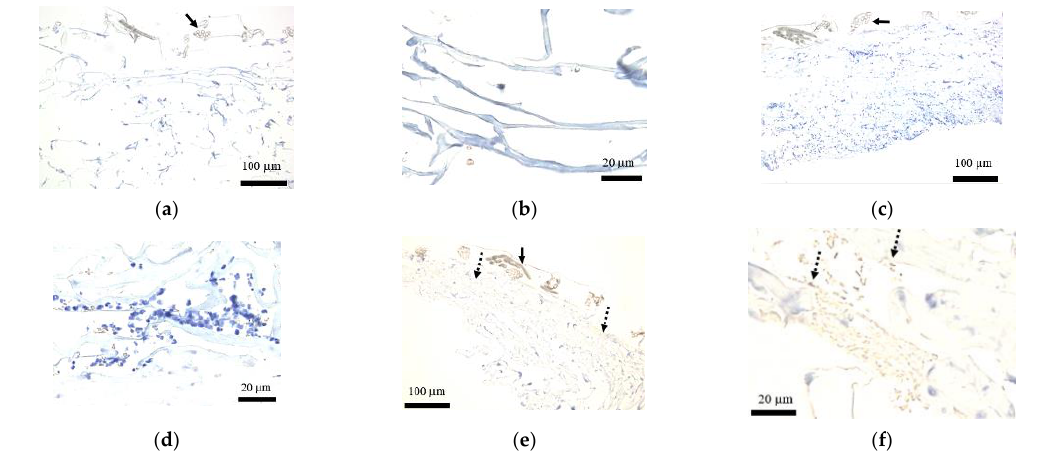
Figure 5. Staining of cytokeratin AE1/AE3 within the artificial dermal scaffold. ( a ) Low power field of view before transplant (40 × ): Cytokeratin AE1/AE3 expression was found on a tissue within the artificial dermis (dashed arrow). Solid arrow represents silicone film. ( b ) High power field of view before transplant (200 × ): Cytokeratin AE1/AE3 expression was found on a micrograft within the artificial dermis (dashed arrow). ( c ) Low power field of view postoperative day 3 (40 × ): Cells stained with cytokeratin AE1/AE3 were predominant on the ulceration side (dashed arrow). Solid arrow represents silicone film. ( d ) High power field of view postoperative day 3 (200 × ): Cells stained with cytokeratin AE1/AE3 expression were found in the collagen sponge (dashed arrow). ( e ) Low power field of view postoperative day 7 (40 × ): The presence of cells with cytokeratin AE1/AE3 expression has increased (dashed arrow) and was detected more on the silicone film side. Solid arrow represents silicone film. ( f ) High power field of view postoperative day 7 (200 × ): A number of cells stained with cytokeratin AE1/AE3 expression were found in the collagen sponge (dashed arrow).